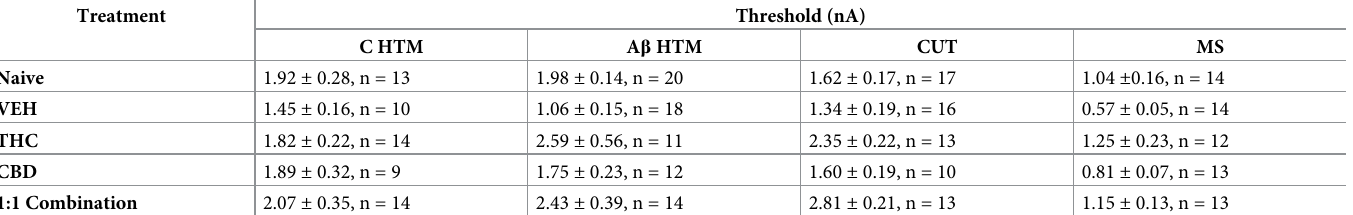
Table 5. Male activation thresholds of sensory neurons in response to intracellular current injection tested to determine differences in soma excitability in response to cannabinoid treatment. Treatment